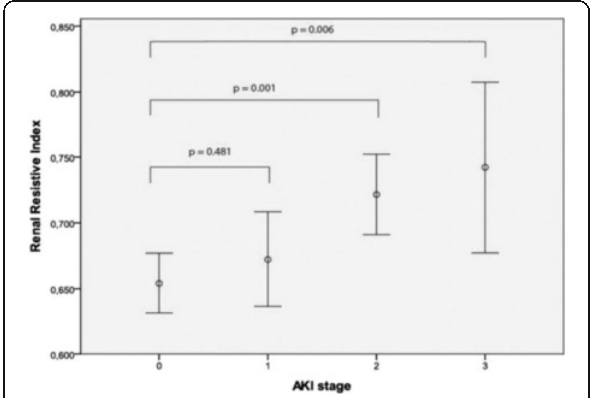
Fig. 12 (abstract A27). RRI for each AKI stage (mean+95% CI)